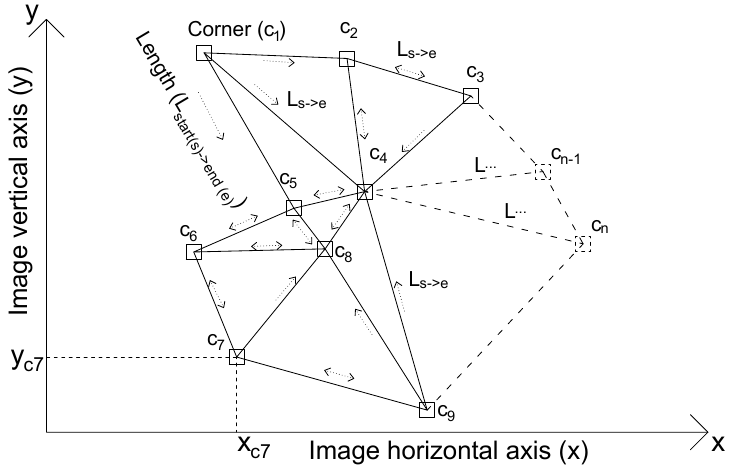
Figure 7. CDNTS layer, nearest three-point selection process schematic